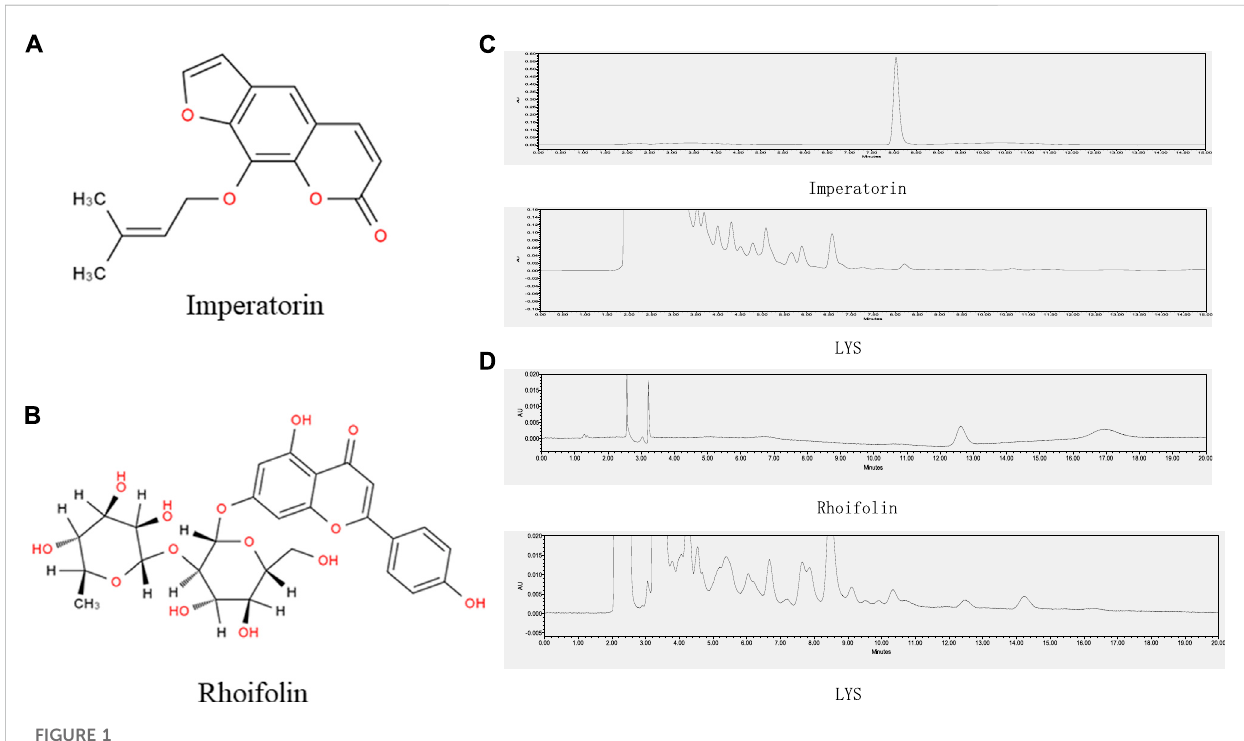
FIGURE 1 Structural formula (A, B) and HPLC of imperatorin and rhoifolin (C, D) . Retention time of imperatorin and rhoifolin were approximately 8.2 and 12.6 min, respectively.